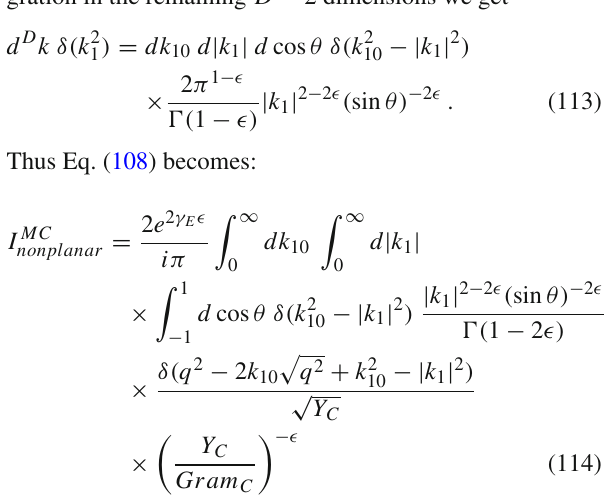
Thus in D = 4 − 2 (cid:5) dimensions after doing the φ inte- gration in the remaining D − 2 dimensions we